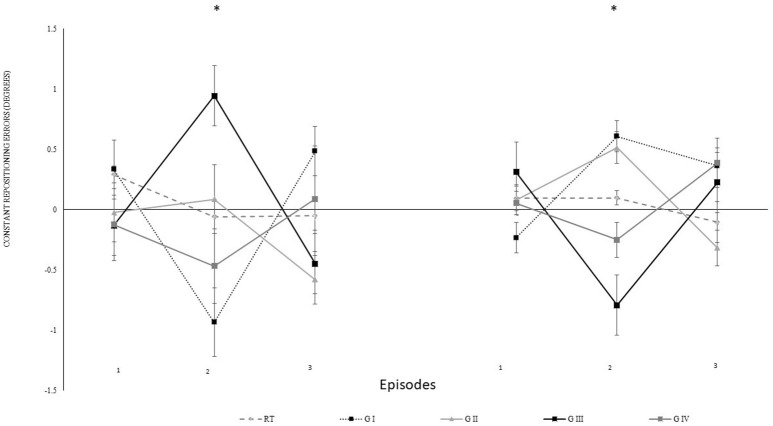
Constant mean and standard error of repositioning error (°) for the experimental II, 2nd and 4th block, also for episodes (1–3). Difference in proprioceptive perceptions in between decomposed mapping conditions have been described for 5 sub-groups i.e., RT: real-time auditory feedback, sub-group I (G I: 40°: under-over-under, 75°: over-under-over), sub-group II (G II: 40°: over-under-over, 75°: over-under-over), sub-group III (G III:40°: over-under-over, 75°: under-over-under), and sub-group IV (G IV: 40°: under-over-under, 75°: under-over-under), and across 3 treatment blocks. The values on left represent 40°, and right 75° (RT: Real-time kinematic auditory feedback). *Represents significant differences.